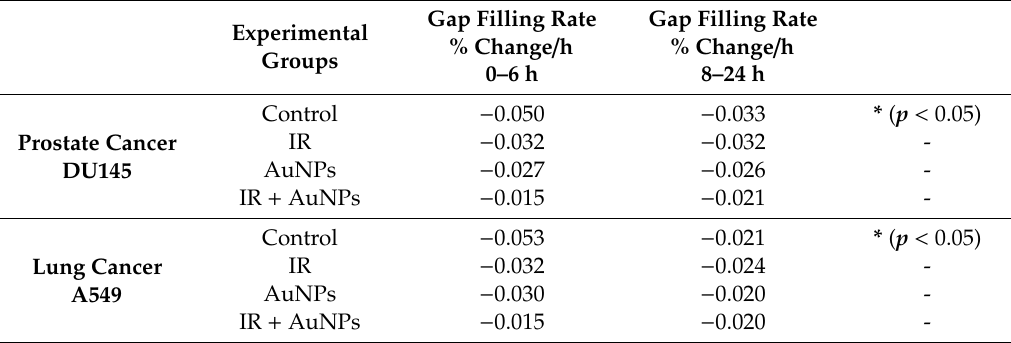
Table 1. Effect of IR and/or AuNPs on the gap-filling rate in prostate (DU145) and Lung (A549) cancer cells. Results expressed as the mean for 3 replicates. Significance of gap closure between 0–6 h compared to 8–24 h is shown as * p < 0.05.